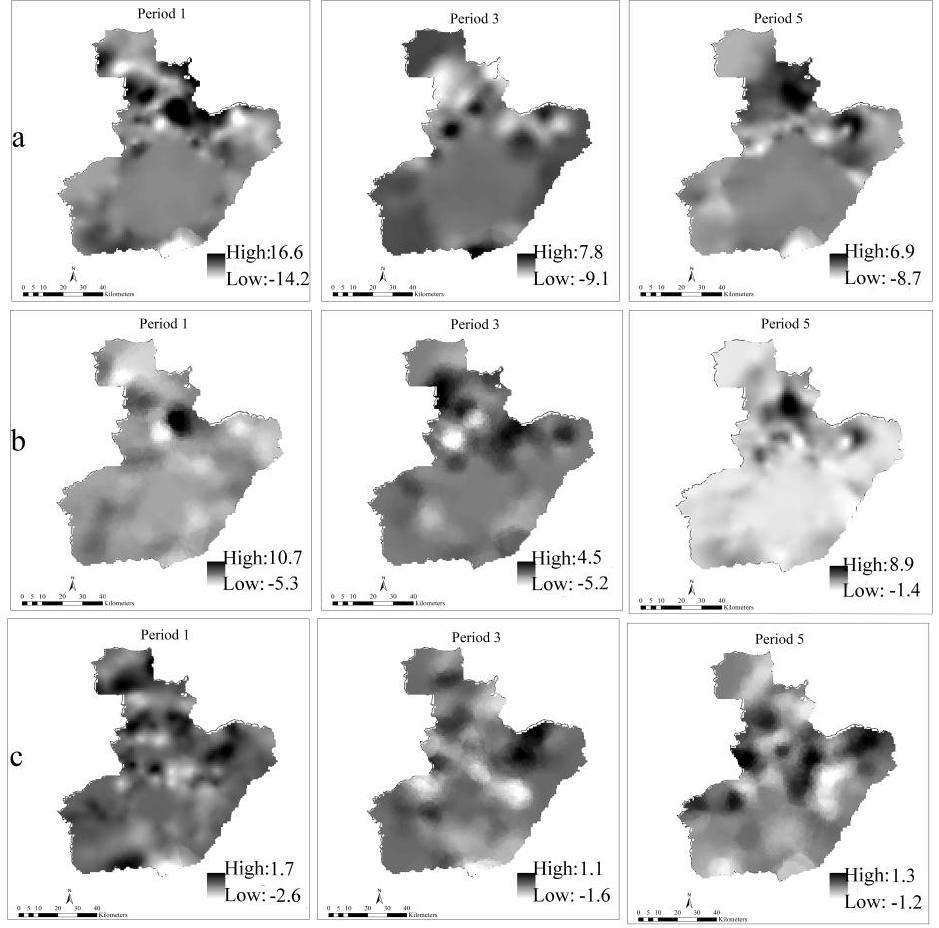
Figure 9. Distribution of the coefficients for GTWR in different periods at the resolution of 100 m. The letters ( a – c ) represent ENTERPRISE, LINE, and DEM respectively.